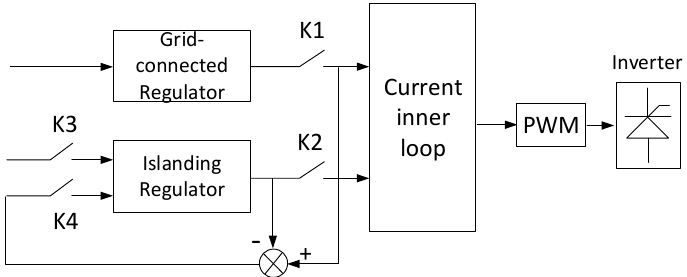
Figure 6. Scheme of regulation state follower from grid-connected mode to islanding mode.